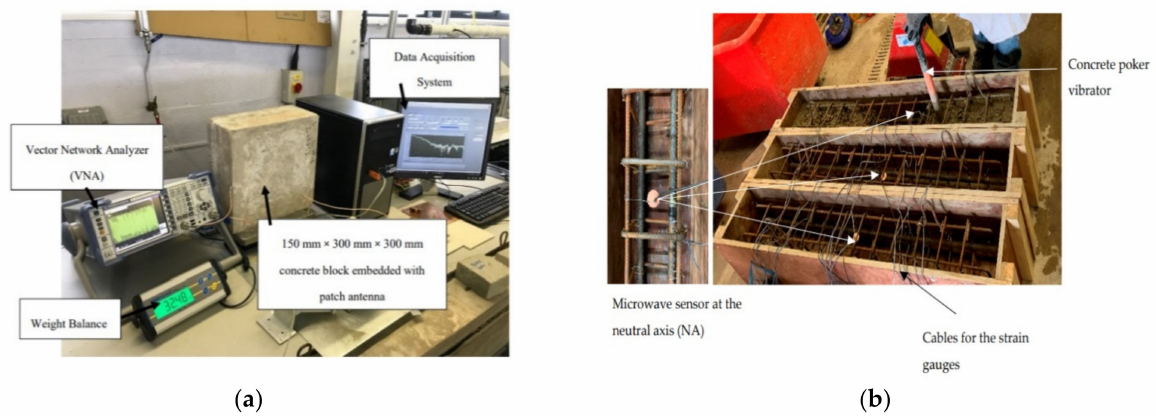
Figure 2. ( a ) Embedded Rectangular patch antenna setup for moisture detection [19], ( b ) Embedded SRR antenna setup for crack detection